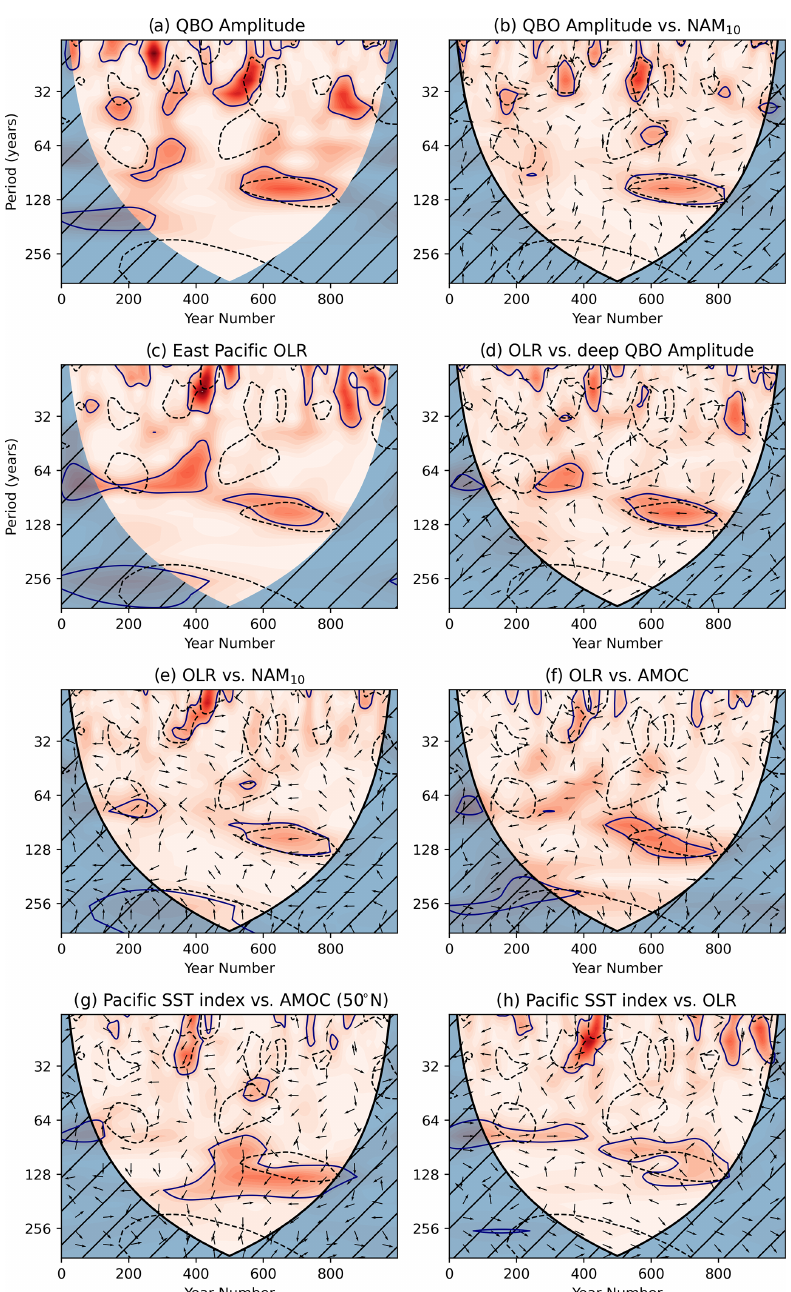
Figure 10. (a) Wavelet power spectrum for the Sep–Nov deep QBO amplitude (see Sect. 2.4). (b) Cross-power spectra between deep QBO amplitude (Sep–Nov) and smoothed NAM 10 (Dec–Mar). (c) Wavelet power spectrum for the Sep–Nov area-weighted average equatorial east Pacific OLR (see Sect. 2.4). (d–f) Cross-power spectra between combinations of east Pacific OLR, deep QBO amplitude (both Sep–Nov means), AMOC at 50 ◦ N (annual mean; all months), and NAM 10 (Dec–Mar) indices, which have all been smoothed with the same Gaussian filter that is used throughout ( σ = 2 years). (g–h) Cross-spectra between a Pacific SST index derived using the loading pattern in Fig. 11 and the east Pacific OLR and AMOC at 50 ◦ N. Indices involved are indicated by the subfigure titles. Shading indicates the cross-power, using the same colour scale as in Figs. 6–8. Solid contours indicate the 95% confidence interval for the power spectrum, and dashed contours show the 95% confidence interval for the NAM 10 spectrum, for ease of comparison. Arrows indicate the relative phase angle between the signals in the